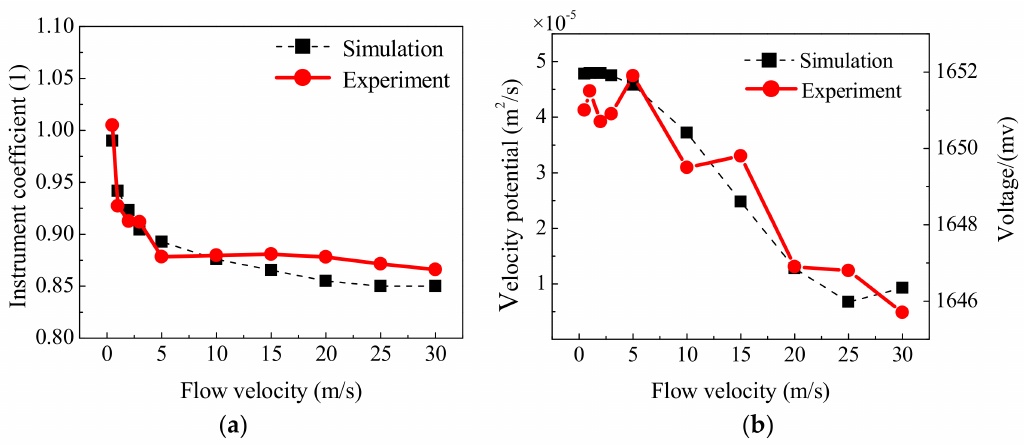
Figure 19. Comparison between the experiment and simulation. ( a ) Instrument coefficient. ( b ) Signal